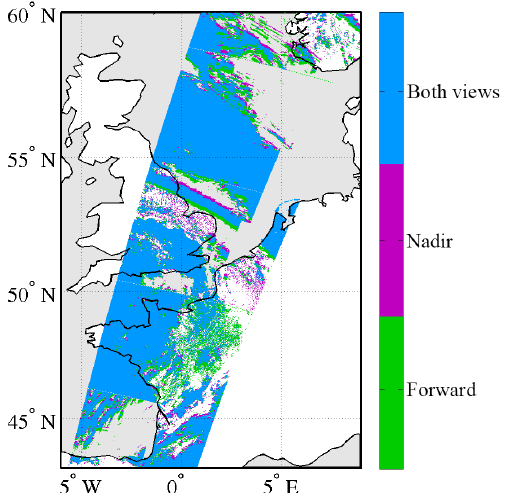
Figure 2. Stereo view effect in nadir/forward cloud screening, for the overpass on 29 July 2008, ca. 10:00UTC (as in Fig. 1). Clouds detected with at least one of four tests in both views, in only nadir and in only forward views are coloured with light blue, magenta and green respectively. To better show the stereo effect, cloud screening over ocean was performed here for both nadir and forward